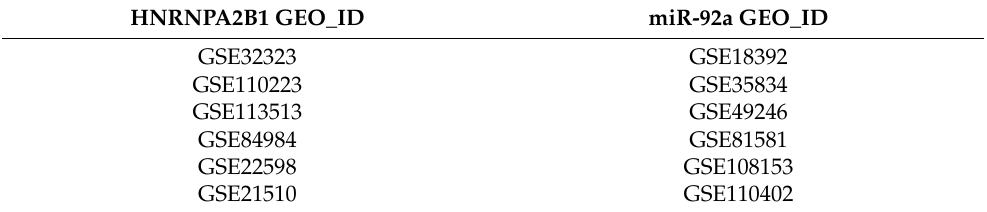
Table A3. GEO datasets.